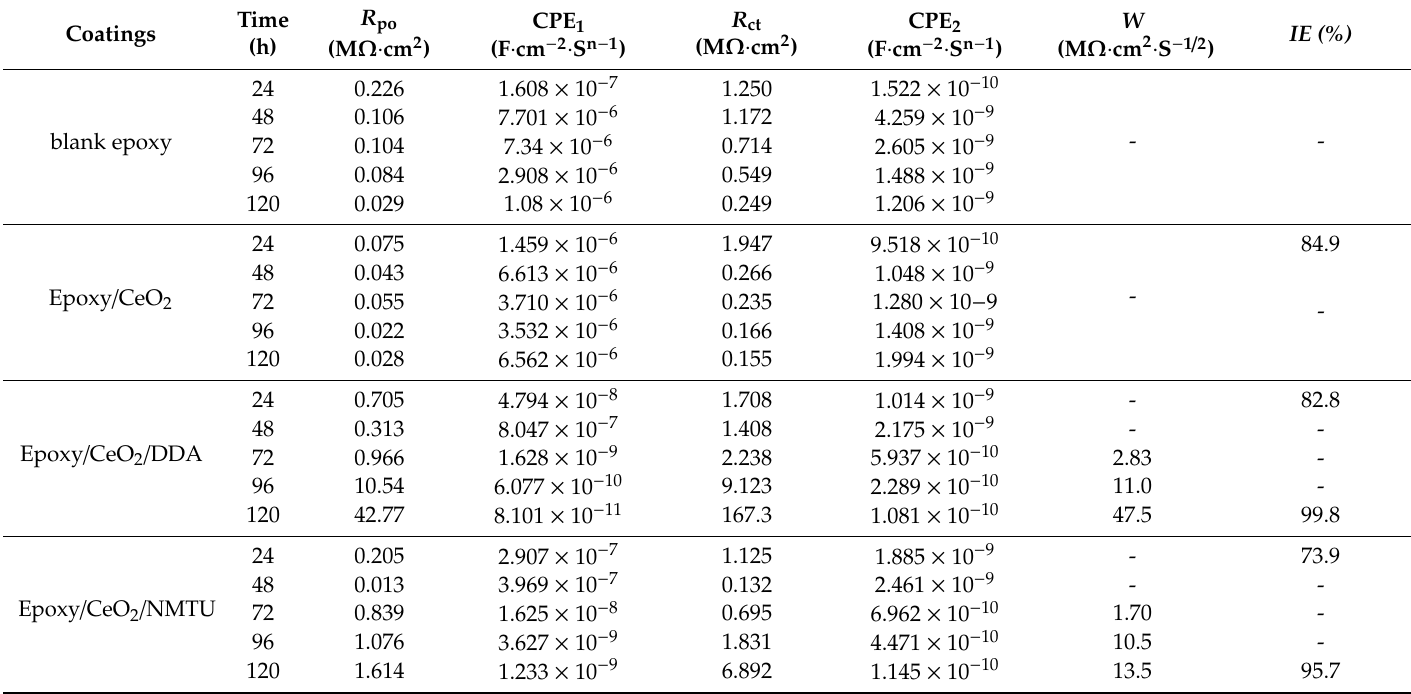
Table 2. The obtained fitted electrochemical values of the electrochemical impedance spectroscopy (EIS) data for the di ff erent coated specimens immersed in 3.5 wt.% NaCl for di ff erent immersion times at room